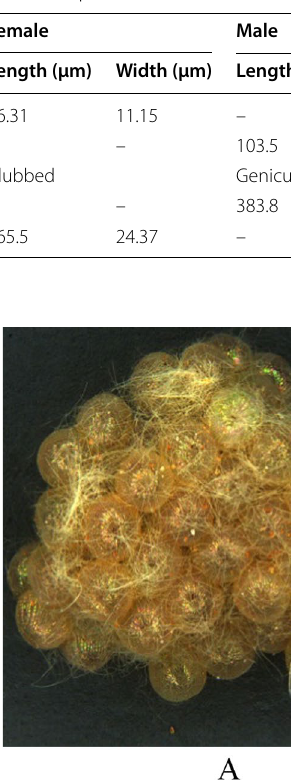
Table 3 Sexual dimorphism in Telenomus remus